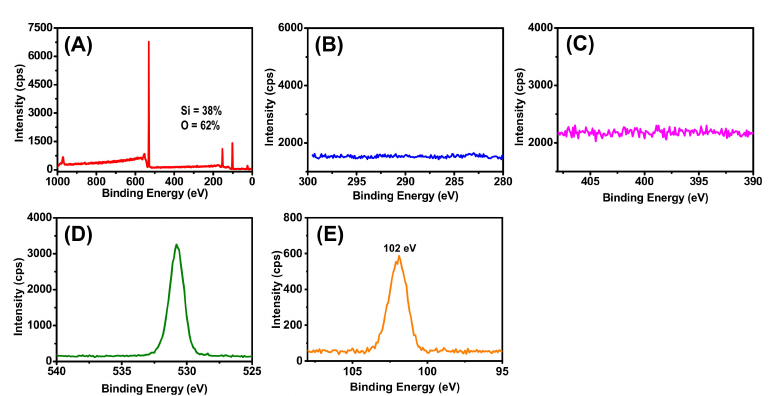
Figure A1. XPS analysis of 10 min plasma oxidized SiO 2 surface. ( A ) wide, ( B ) C 1s, ( C ) N 1s, ( D ) O 1s, and ( E ) Si 2p spectra.